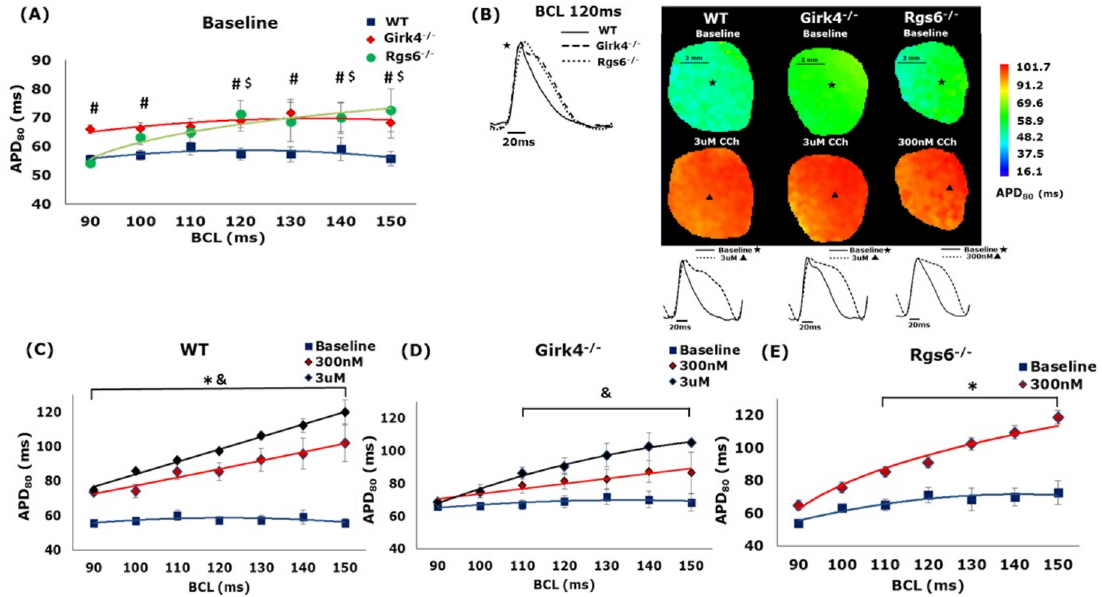
Fig 2. The effect of GIRK4 and RGS6 ablation on APD 80 . (A) Change in average APD 80 with decreasing BCL in WT, Girk4 -/- , and Rgs6 -/- hearts. (‘#’ denotes statistical significance of p < 0.05 between WT and Girk4 -/- . ‘$’ denotes statistical significance of p < 0.05 between WT and Rgs6 -/- ). (B) Representative 2D APD 80 maps from WT, Girk4 -/- , and Rgs6 -/- hearts, constructed at BCL = 120 ms both at baseline and post-CCh injection. Representative action potential traces are shown at baseline (top panel, pixels marked by (cid:3) ) and post-CCh (bottom panel, pixels marked by Δ ). (C-E) The effect of CCh on APD 80 at decreasing BCL in WT, Girk4 -/- , and Rgs6 -/- hearts. (‘ (cid:3) ’ denotes statistical significance of p < 0.05 between baseline and 300nM CCh; ‘&’ denotes statistical significance of p < 0.05 between baseline and 3uM CCh). n = 8, 5, 8 for WT, Rgs6 -/- , and Girk4 -/- , respectively. All statistics performed using 1-way ANOVA.